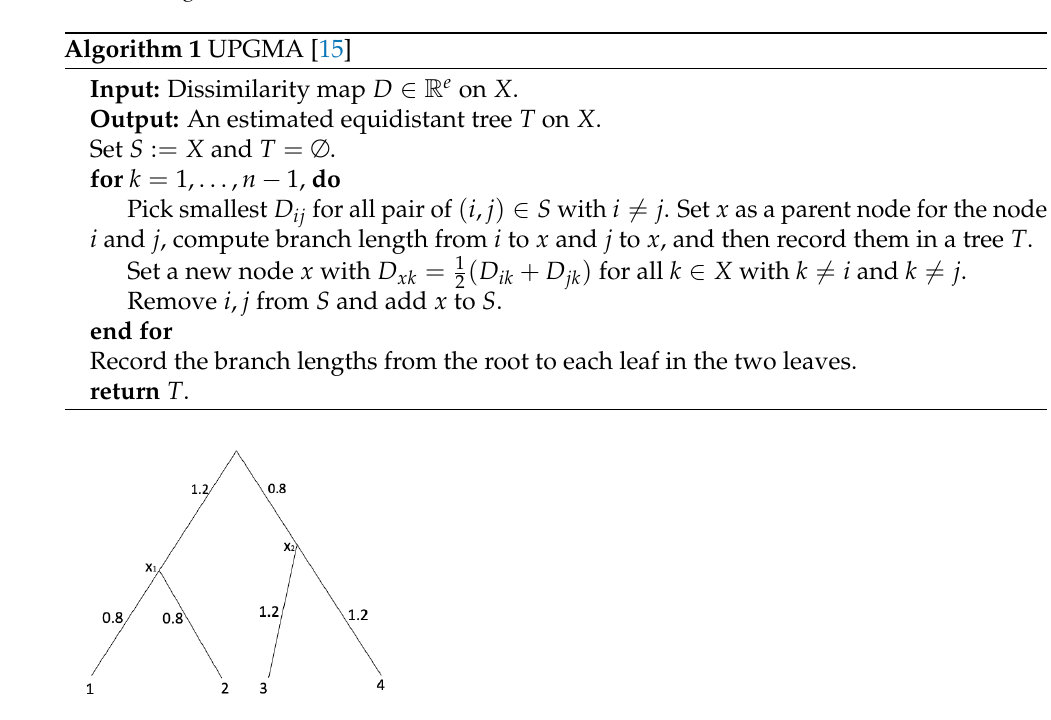
Figure 2. Example for Algorithm